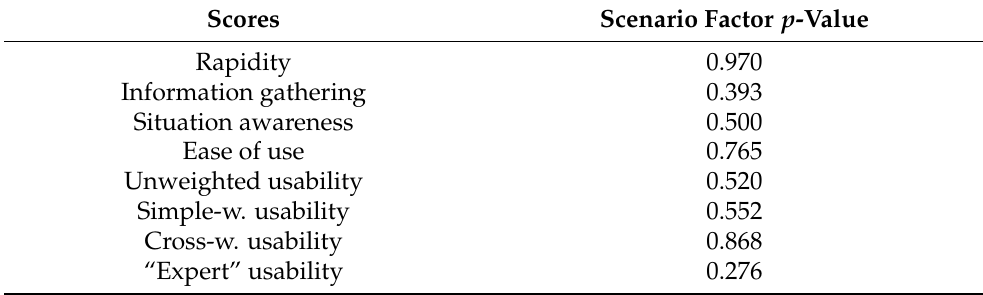
Table 3. Desktop application: between subjects ANOVA on quality factors and usability scores with interaction technique and scenario